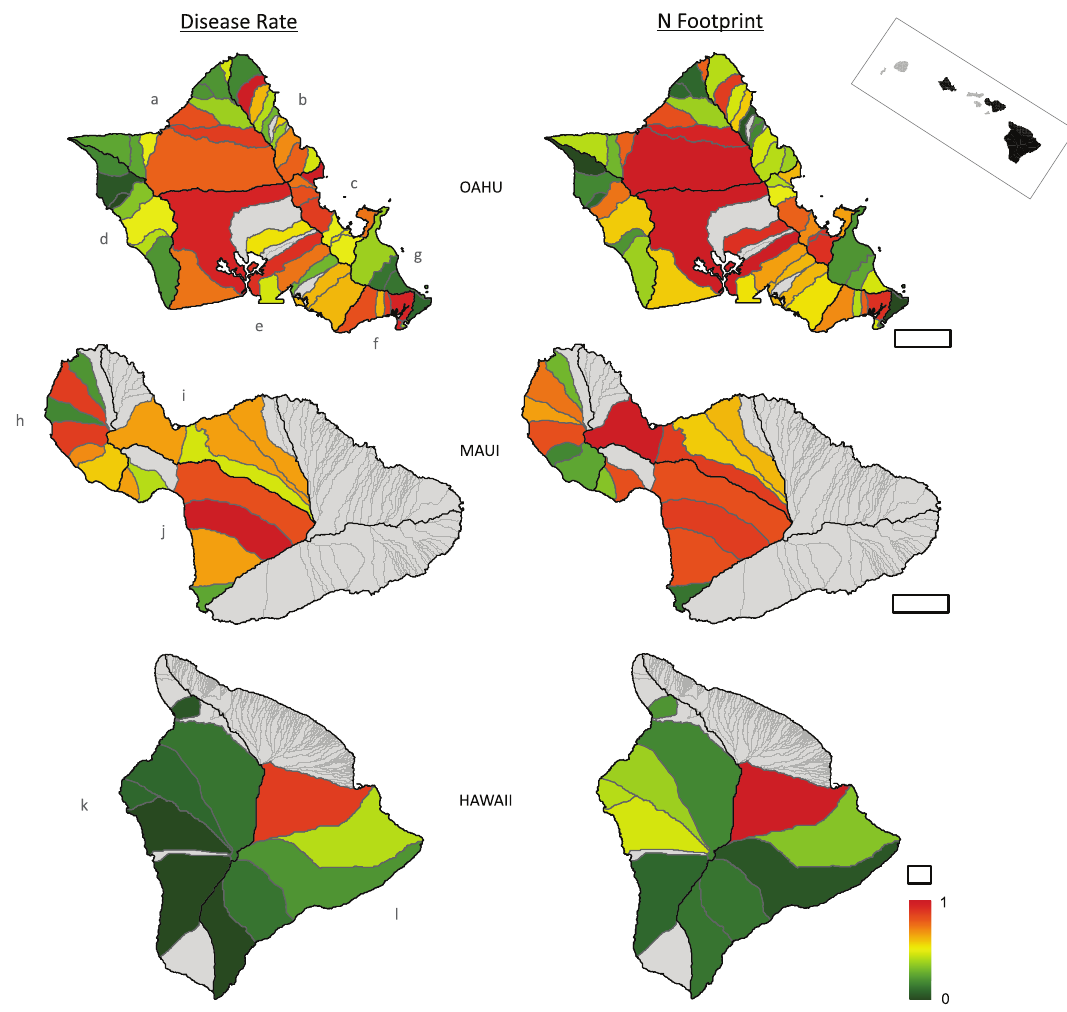
Figure 4. Spatial analyses reveal that disease rates are highest in watersheds where human land use impacts are greatest. Left panels plot the standardized diseaserates in watersheds on all islands. Right panels display the Nitrogen-footprint index, orthecombined influence of local factors that generate, deliver and retain N in coastal waters (see Methods). Geographically weighted regression (GWR) demonstrates that disease rates in watersheds increase with local and proximate eutrophication ( r 2 =0.72). Central Oahu and Maui with widespread pineapple and sugar agriculture have high disease rates. Less impacted areas in Oahu and Hawaii have lower disease rates. Island regions are: Oahu (a) North Shore, (b) Kahuku, (c) Kaneohe, (d) Waianae, (e) South Shore, (f) Maunalua, (g) Waimanalo; Maui (h) West Maui, (i) North Maui, (j) South Maui; Hawaii (k) Kona, (l) Hilo. Grey lines are watershed boundaries, black lines are hydrographic regions used in the time series (Fig. 3), and filled grey polygons are watersheds lacking turtle data. Scale bar is 10km for each island, inset map at top right displays the main Hawaiian Islands. Both panel series use the color ramp at bottom